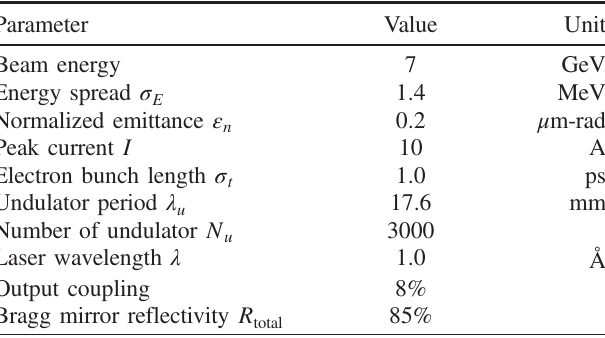
TABLE II. Simulation parameters for X-ray